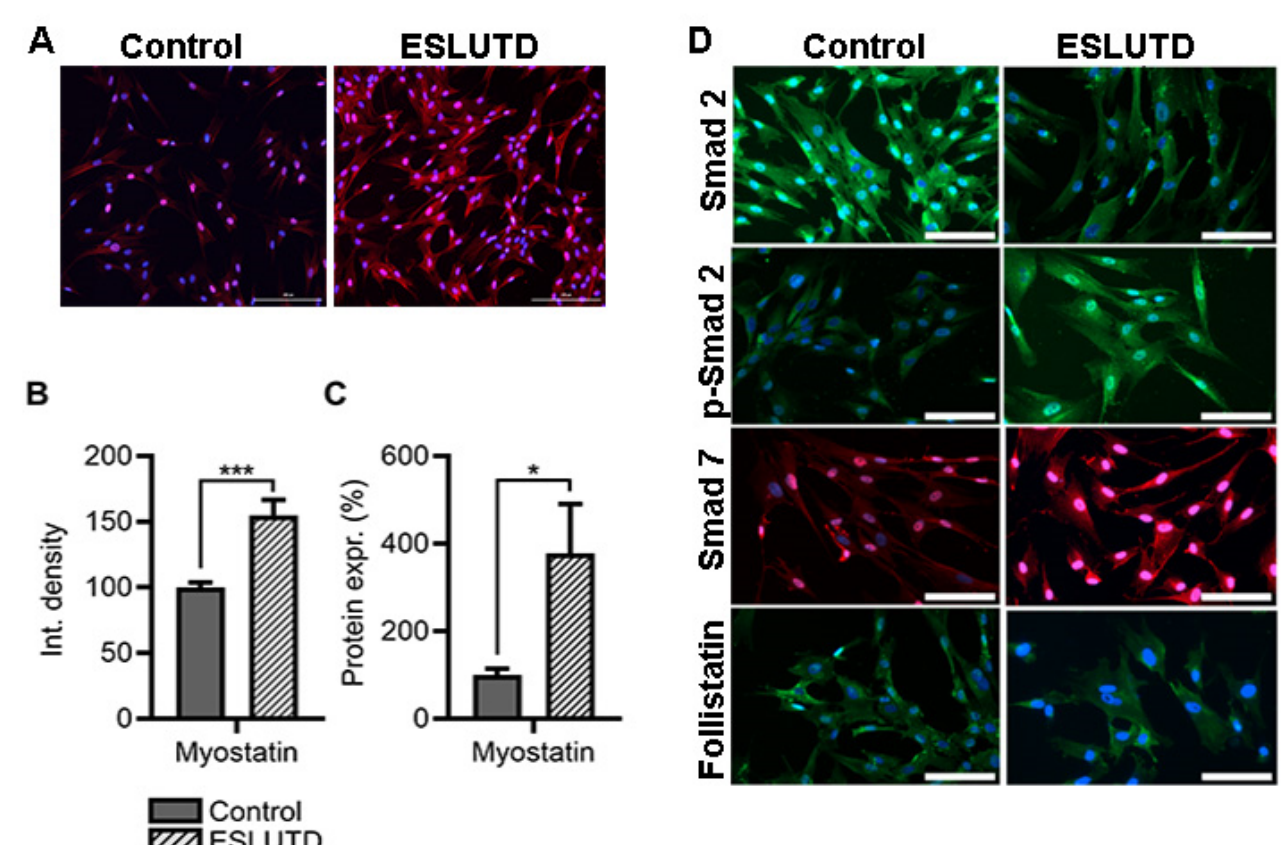
Figure 4. Myostatin signaling pathway protein expression in hSMCs. ( A ) Representative fluorescence images of control and ESLUTD hSMC with myostatin antibody (red), scale bar 100 μ m. ( B ) Quantification of microscopic images showed a significant increase in myostatin expression in ESLUTD compared to control. Positive myostatin immunostaining in ESLUTD was measured and compared to control (100%). Bars represent mean ± SEM, n = 4 for each group and 8 images/images. Statistical analysis with unpaired t -test; *** p ≤ 0.001. ( C ) Quantification at protein level by WES showed significantly higher expression of myostatin compared to control hSMCs (100%) * p ≤ 0.05. ( D ) Myostatin downstream proteins Smad 2 (green), p-Smad 2 (green), Smad 7 (red) and natural myostatin inhibitor follistatin (green). Nuclei were stained with DAPI (blue). Scale bar 200 μ m.